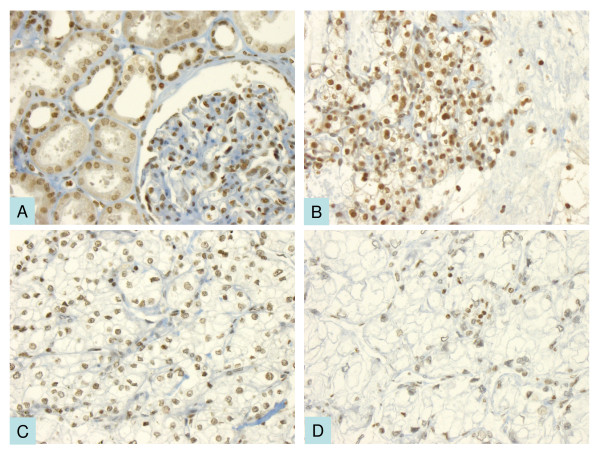
XAF1 immunohistochemistry. A Normal renal tissue with prominent nuclear XAF1 expression in the tubuli and glomerular cells. B-D XAF1 expression in clear cell carcinomas with high (B), intermediate (C) and low (D) immunoreactive scores respectively.